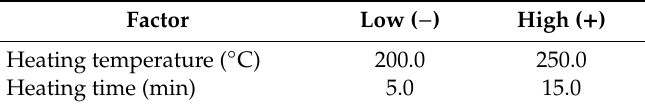
Table 4. Levels of the 3 2 factorial design.